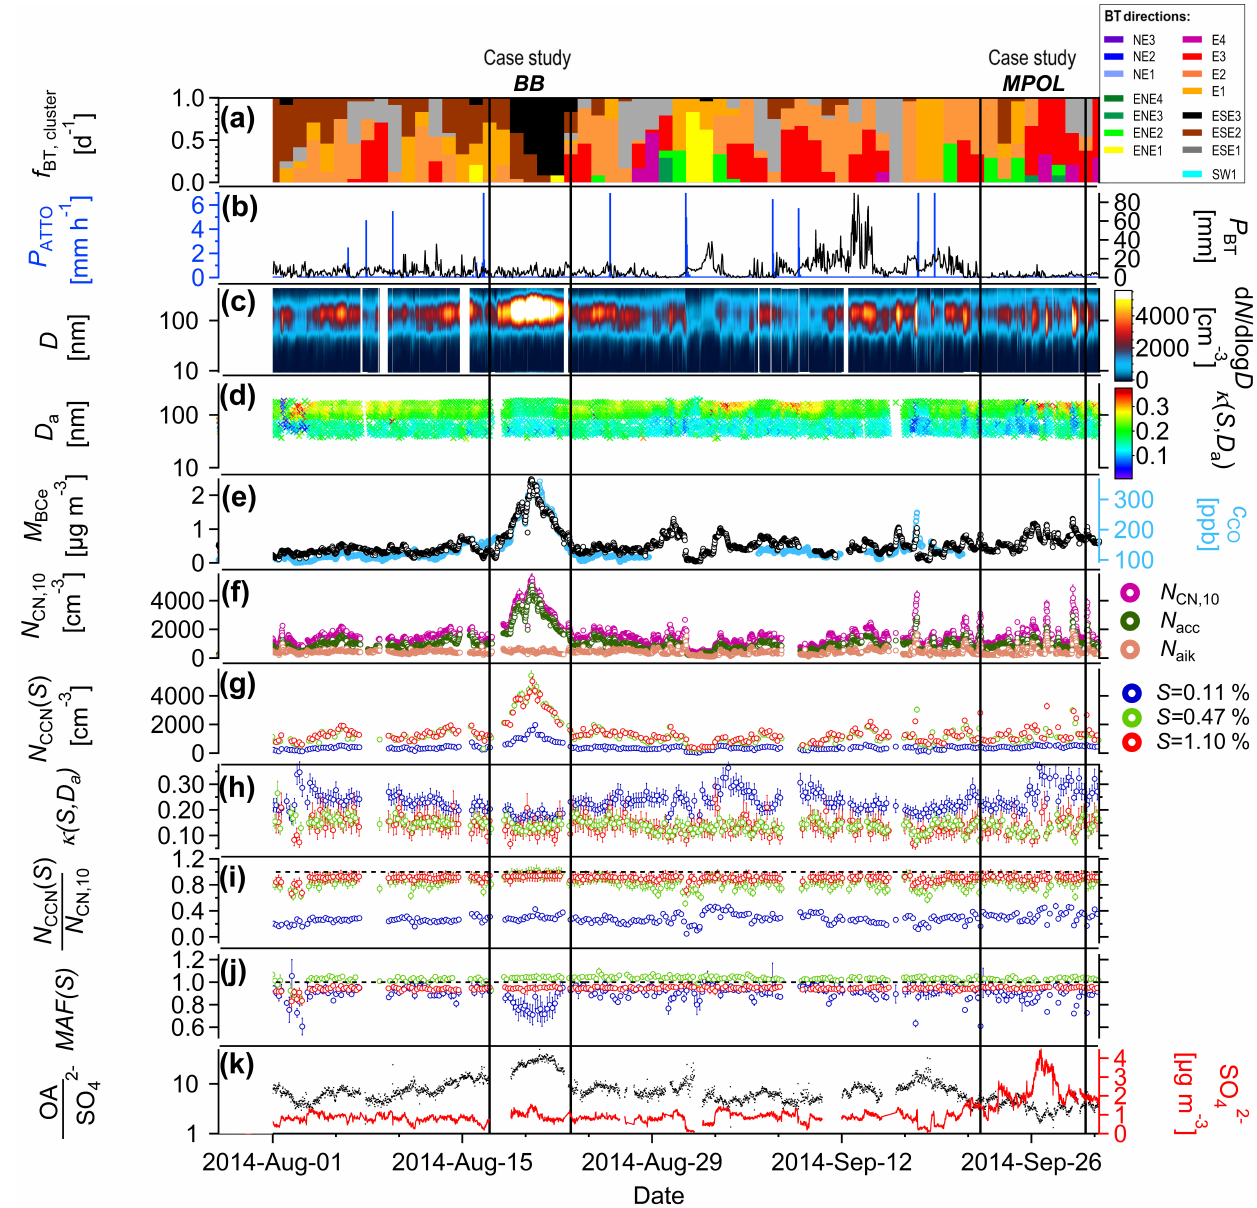
Figure 4. Overview plot illustrating selected meteorological, trace gas, aerosol, and CCN time series for representative dry-season conditions in the central Amazon. The shown time period from 1 August to 31 September covers the most polluted time frame throughout the entire CCN measurement period. Individual panels represent (a) daily frequency of occurrence of 15 different BT clusters, f BT , cluster , with color code corresponding to Fig. S1; (b) precipitation rate ( P ATTO ) measured locally at ATTO and cumulative precipitation from BT analysis ( P BT ) as a measure for aerosol wet deposition; (c) SMPS-derived time series of number size distributions spanning nucleation, Aitken, and accumulation modes; (d) CCNC-derived time series of κ(S,D a ) size distributions; (e) concentrations of biomass burning tracers, CO mole fraction ( c CO ) and BC e mass concentration ( M BC ); (f) total number concentrations of the entire aerosol population ( N CN , 10 ), Aitken mode particles ( N Ait ), e and accumulation mode particles ( N acc ); (g) CCN concentrations, N CCN (S ), for selected supersaturations S ; (h) hygroscopicity parameter, κ(S,D a ), for selected S ; (i) CCN efficiencies, N CCN (S)/N CN , 10 , for selected S ; (j) maximum activated fraction, MAF( S ), for selected S ; and (k) ACSM-derived sulfate mass concentration ( M sulfate ) and organic-to-sulfate ratio (OA / SO 2 − ). All CCN data are provided at the 4 original time resolution of about 4.5h. Vertical lines highlight BB case study on biomass burning conditions for detailed analysis in Sect. 3.6 and MPOL case study on mixed pollution conditions for detailed analysis in Sect.